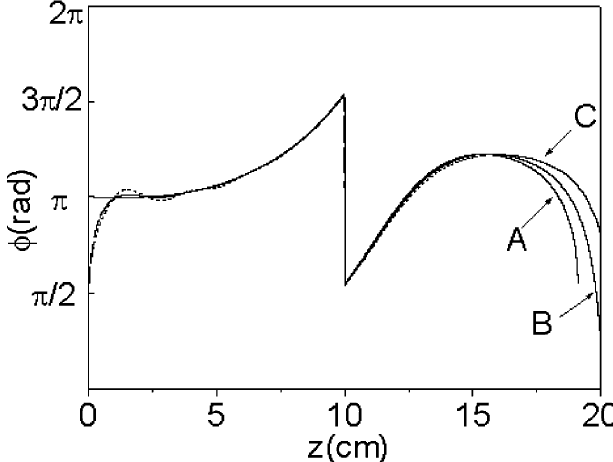
(cid:1) 0 : 0 cm , (B) r 0